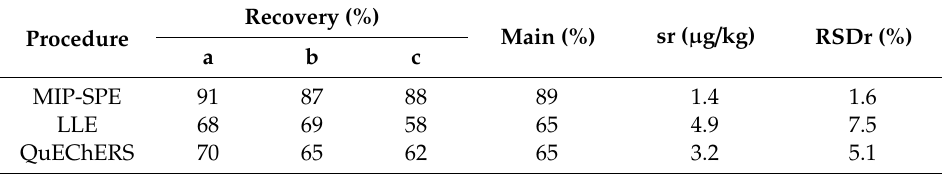
Table 2. Recovery of ZON from spiked maize oil samples using different extraction procedures.